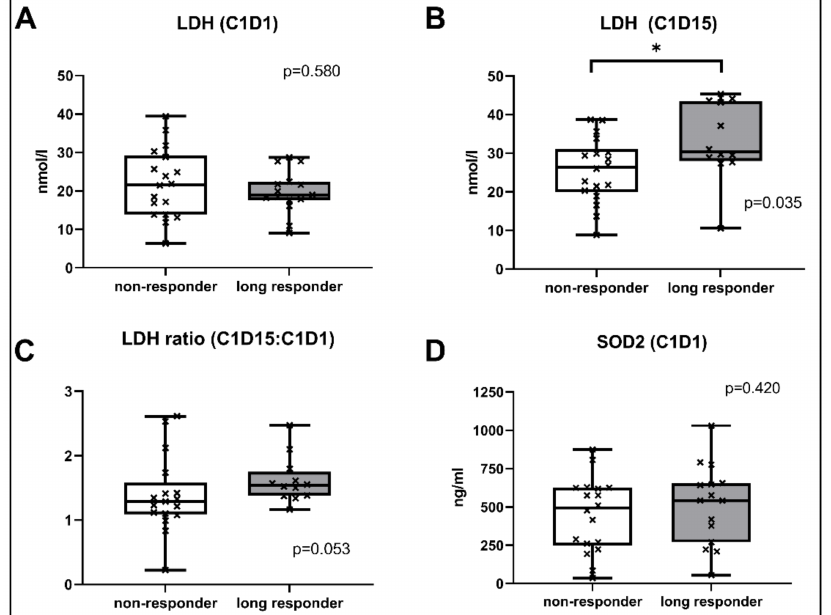
Figure 2. Comparison of the LDH levels at C1D1 ( A ), C1D15 ( B ), the LDH ratio ( C ) or SOD2 levels at C1D1 ( D ) between long responders and early non-responders. * p -value < 0.05; LDH: Lactate dehydrogenase, SOD2: Superoxide dismutase